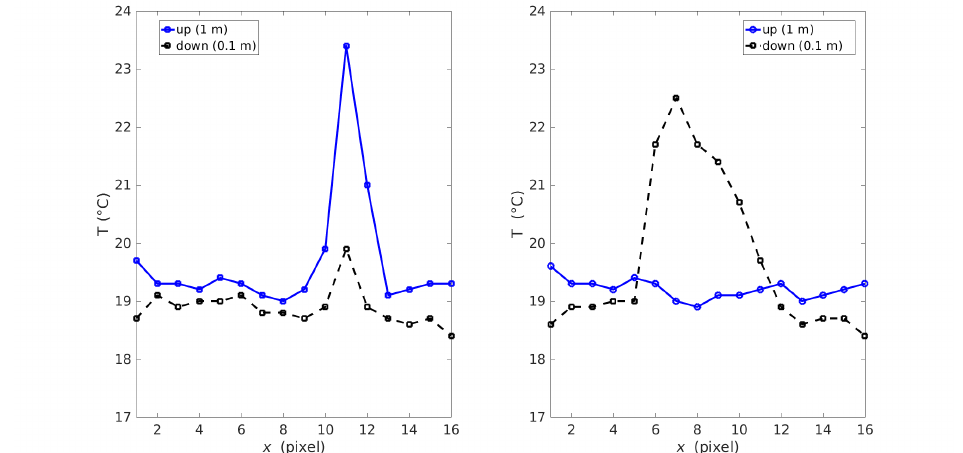
Figure 2. A schema of the data-collection environment with the two types of sensors used for the eHomeSeniors dataset.